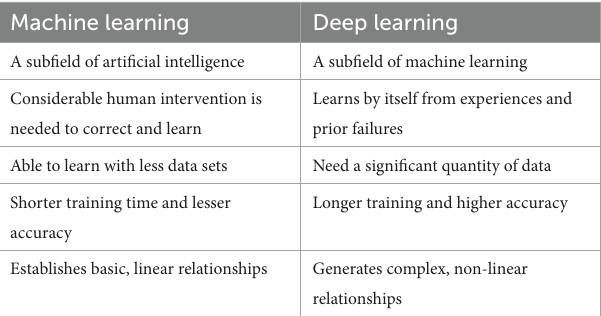
TABLE 2 Differences between machine learning and deep learning.